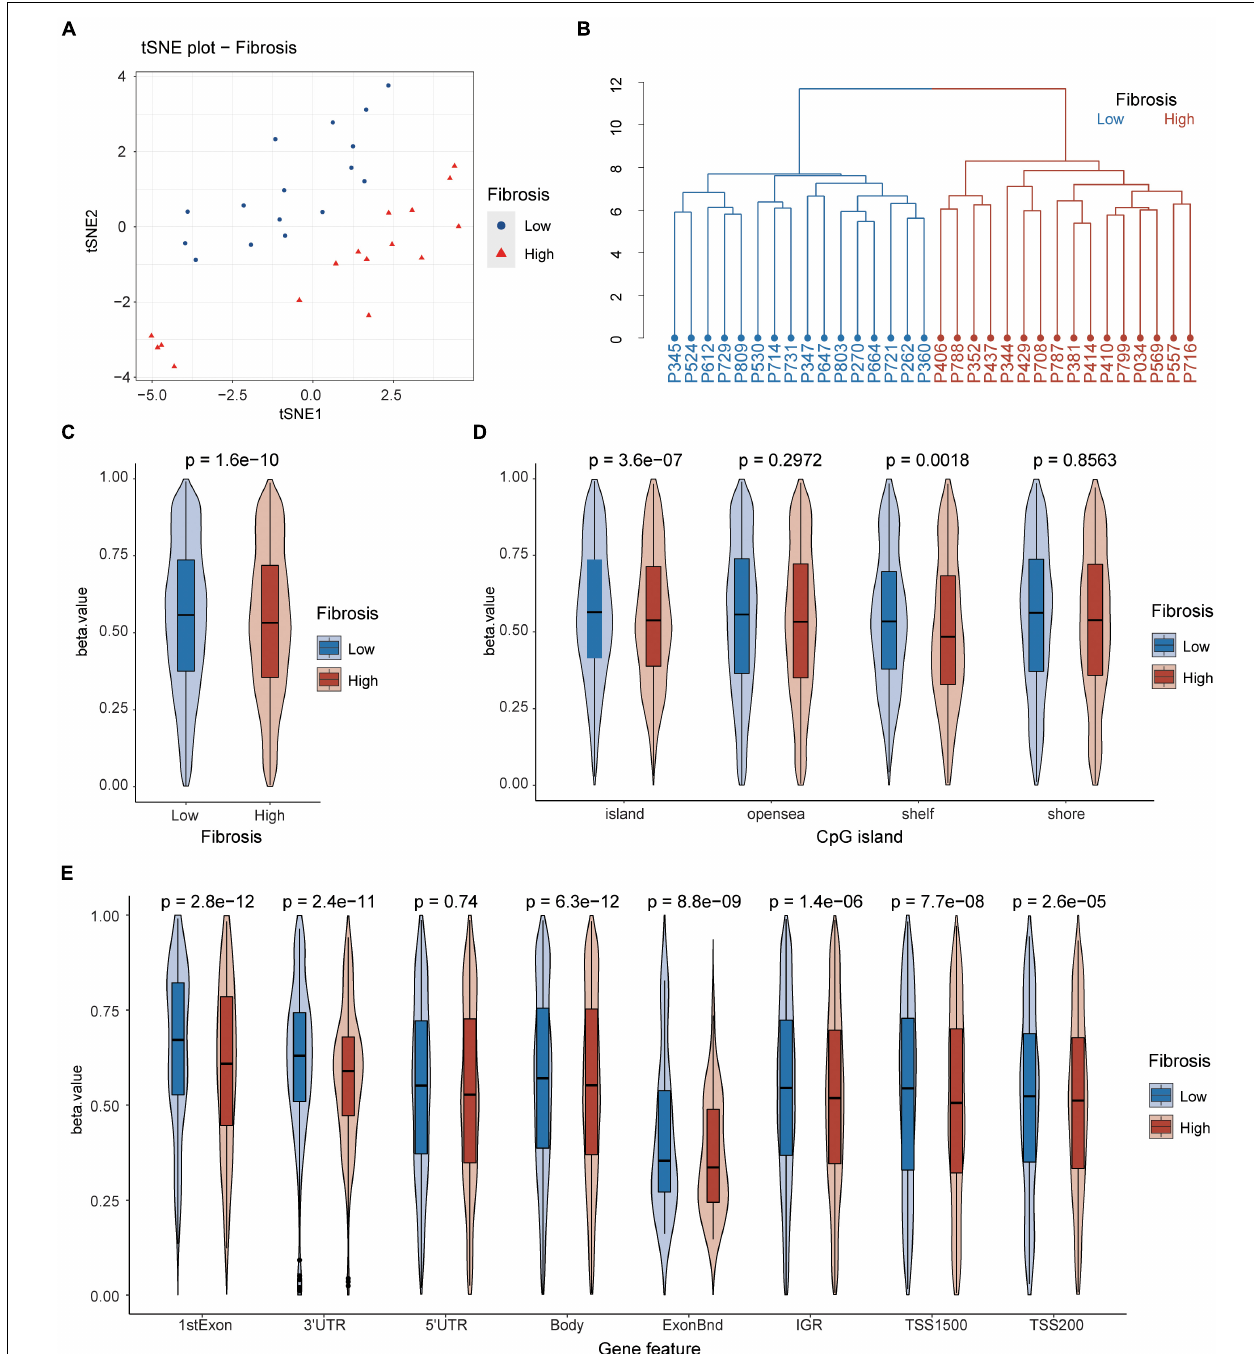
FIGURE 1 | The blood DNA methylation status in NAFLD patients with different levels of liver fibrosis. The SLF and NSLF groups of NAFLD patients were stratified with the t-SNE analysis (A) and the unsupervised hierarchical clustering analysis (B) based on the overall blood DNA methylation status. (C) The methylation levels (i.e., the beta value) of blood DNA in the SLF and NSLF groups. (D,E) Comparison of the methylation levels of different CpG island regions (D) and different gene regions (E) of blood DNA in the SLF and NSLF groups. SLF, significant liver fibrosis; NSLF, non-significant liver fibrosis.